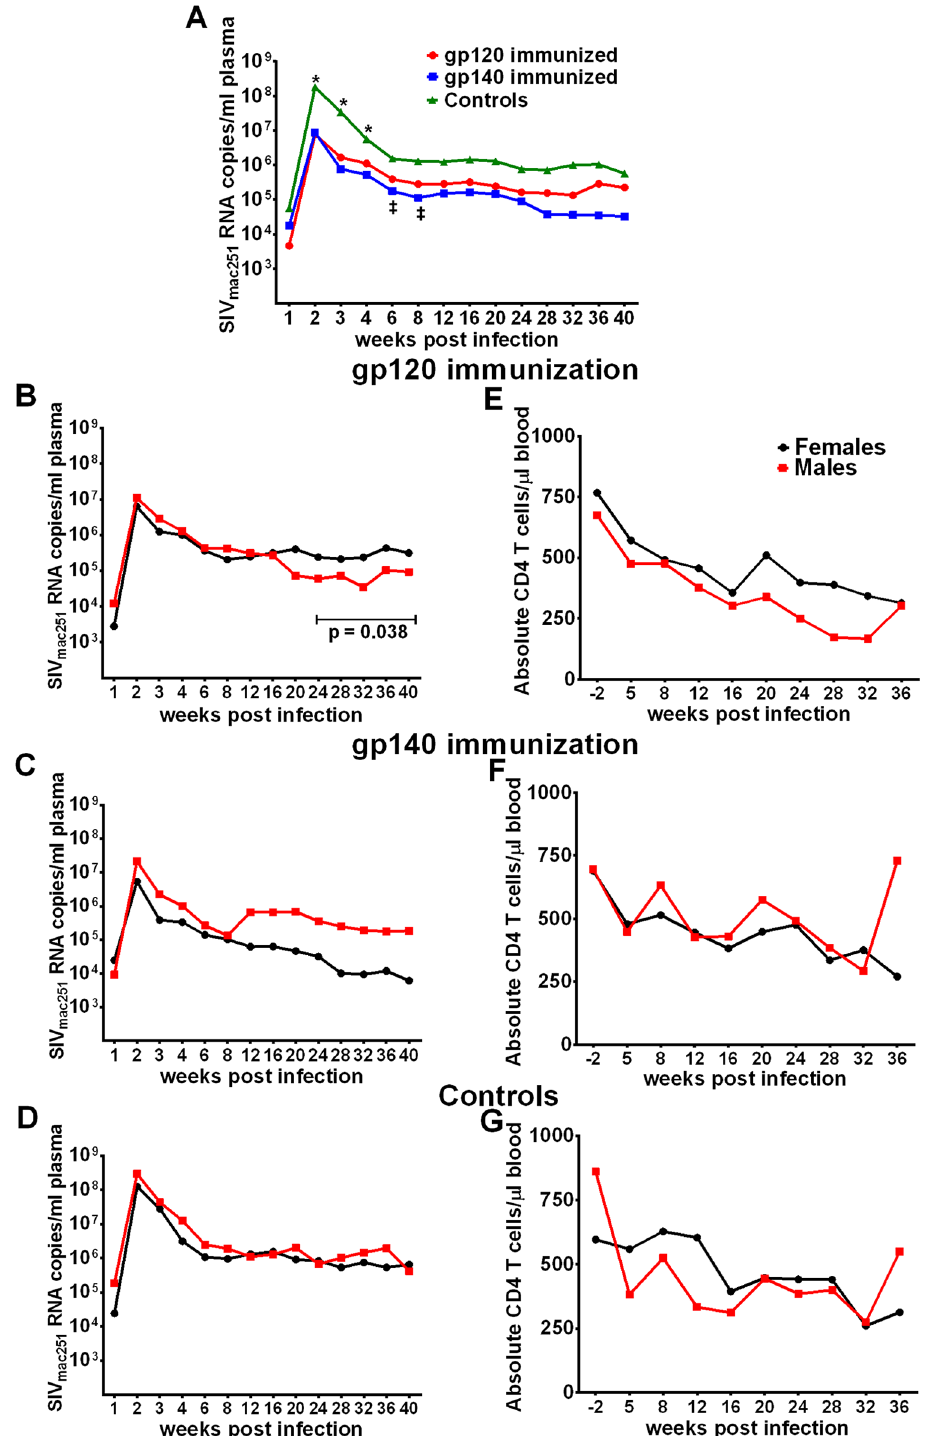
Fig 4. Viral loads post-infection by immunization group and sex. (A) Geometric mean plasma viral loads by immunization group. (B-D) Geometric mean plasma viral loads and (E-G) mean CD4 T cell counts in males and females in gp120, gp140, and control macaque